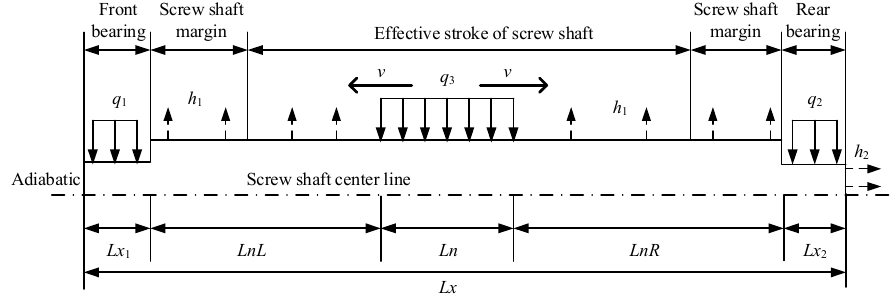
Figure 4. Thermal characteristics analysis model of ball screw feed system.